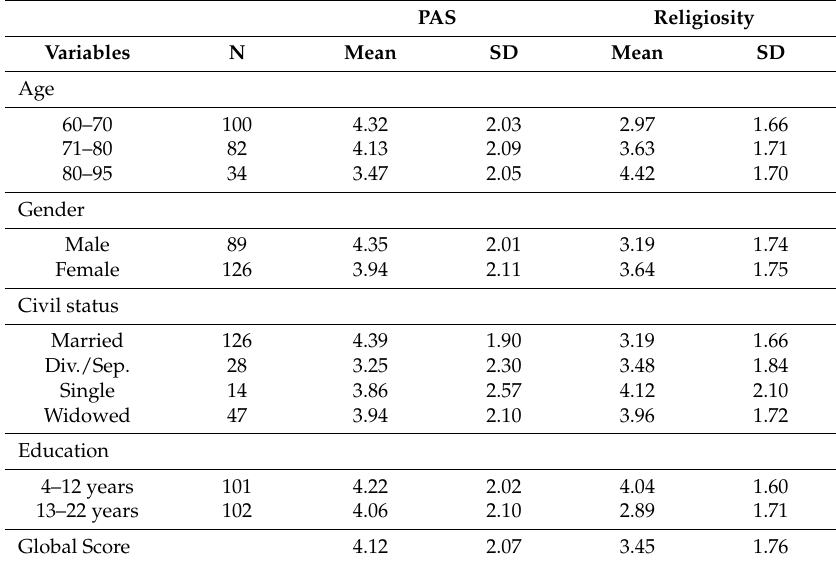
Table 1. Mean scores and standard deviations for the attitude toward PAS (Physician assisted suicide) and for religiosity according to various sociodemographic characteristics (N = 216).